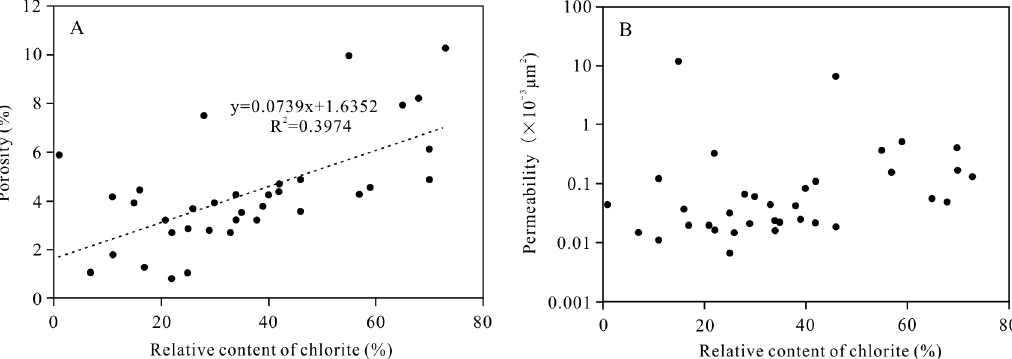
Figure 11. Relationship between relative content of chlorite and ( A ) porosity and ( B ) permeability.